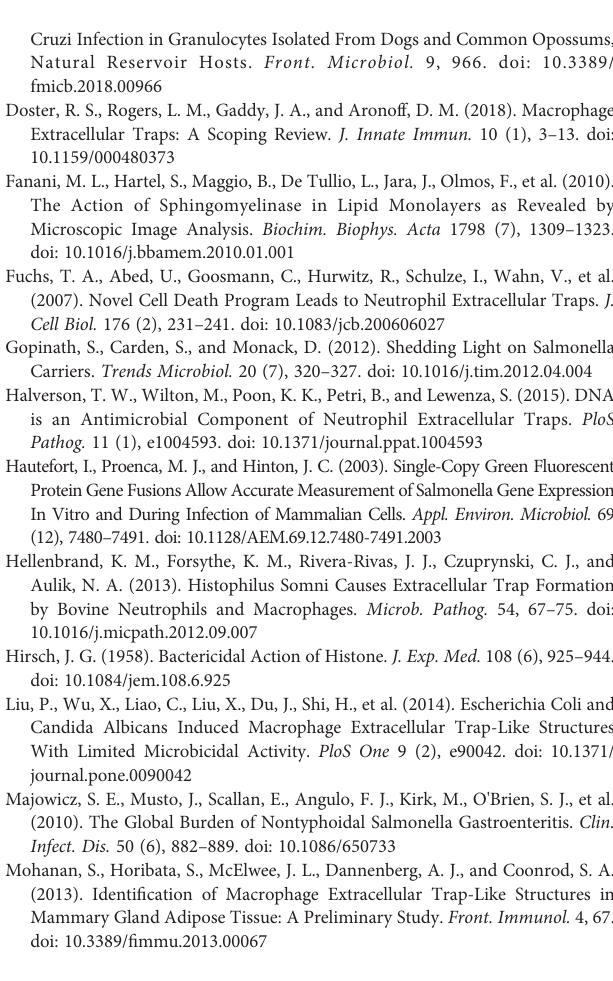
Supplementary Figure 1 | Sterile MET release evaluation. Confocal microscopy images of J774A.1 macrophage extracellular trap release at t = 60 minutes post incubation with supernatant of other culture. Left: Control, J774A.1 cells cultured with fresh medium. Center: J774A.1 cells post incubation with cell supernatant. Right: J774A.1 cells cultured with cell supernatant, pre-treated with DNAse I. WGA staining is shown in red and DNA in blue. The arrows point out MET release. The scale bar represents 10 µm. Supplementary Figure 2 | MET release after Salmonella infection at higher bacteria load. Salmonella enterica serovar Typhimurium LVR01 infection of J774A.1 macrophages at t = 10, 30, and 60 minutes post exposition to bacteria at a MOI 100:1. Maximum intensity z-projections are shown for membrane visualization with